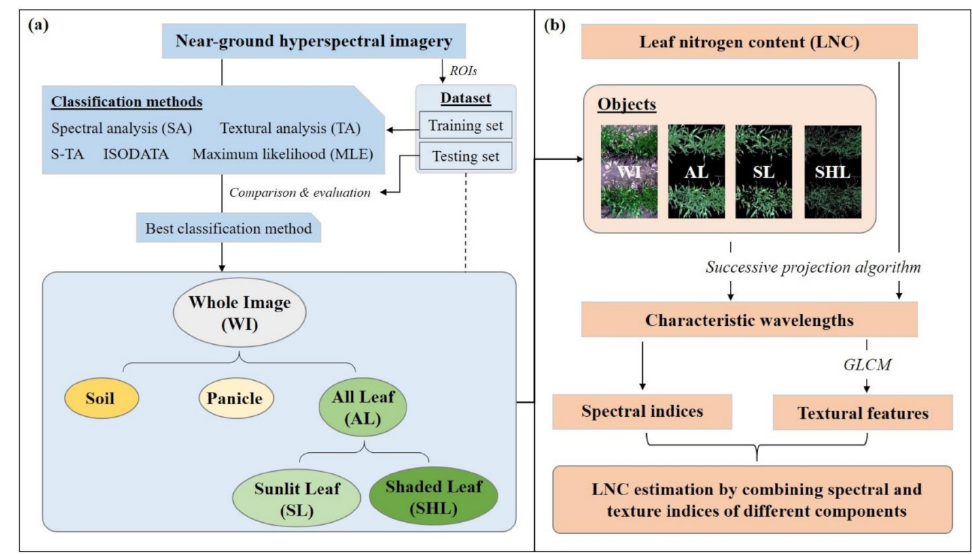
Figure 2. Flowchart for ( a ) image classification and ( b ) leaf nitrogen content (LNC)